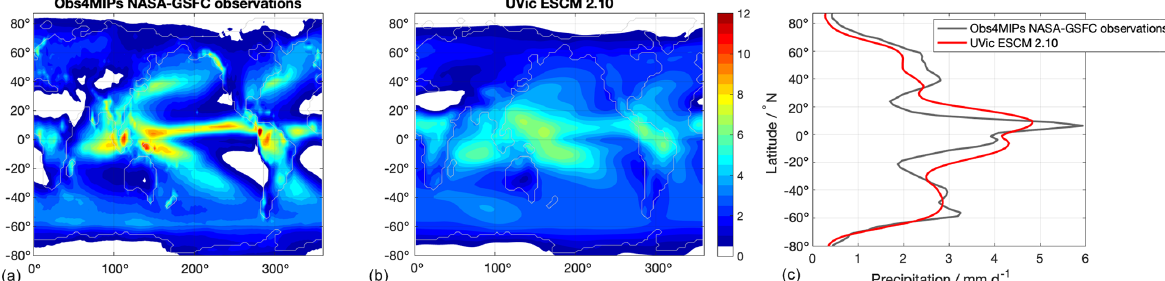
Figure 5. Mean precipitation flux for the period 1979–2013 (in mmd − 1 ) from Obs4MIP (Adler et al., 2003) ( a ; grey line in c ) and the UVic ESCM 2.10 ( b ; red line in c ), and zonally averaged values as a function of latitude (c) .